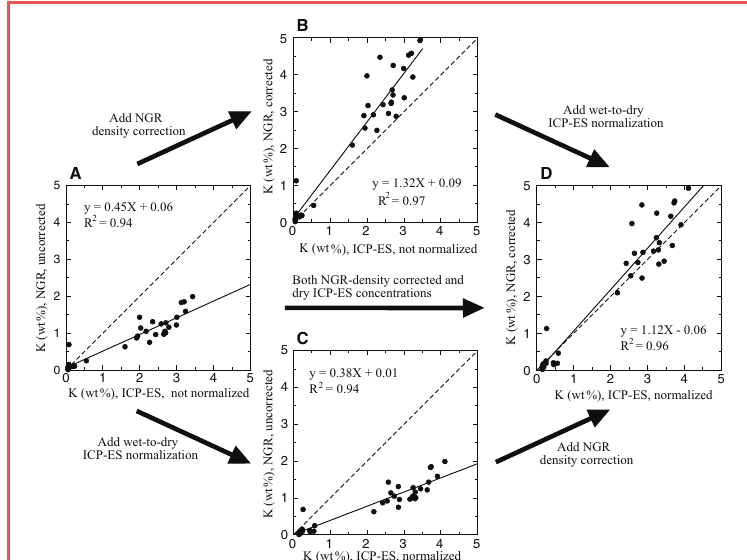
Figure 2. ICP-ES vs. NGR concentrations of K wt% for 38 samples from 4 holes in the South Pacific Gyre. [A] Raw data before the NGR data was density corrected and before the ICP-ES data were normalized to anhydrous values. [B] The K wt% correlation plot after the NGR estimates have been density corrected, but without the normalization of ICP-ES concentrations. [C] The normalized ICP-ES concentrations of K wt% plotted against the NGR data that have not been density corrected. [D] The final results correlating normalized ICP-ES concentrations of K wt% with the density-corrected NGR estimates of K